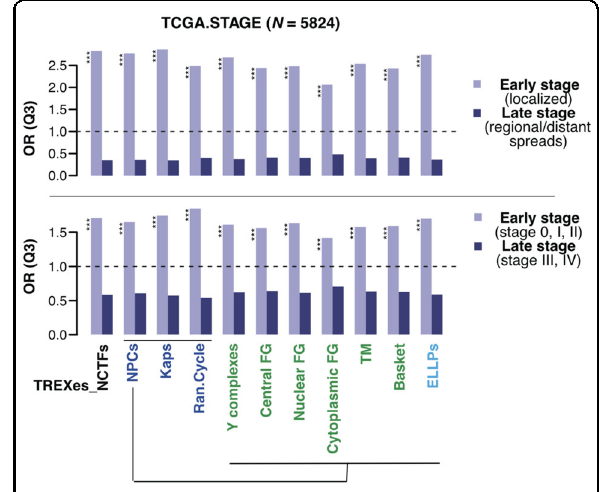
Fig. 5 TREXes and NCTFs show distinctive enrichment patterns by cancer stage. Comparison of the odds ratios of TREXes and NCTF subclasses in early- and late-stage cancers, as obtained from the GTEx database. Bar plot representing the odds ratios (ORs, Q3) of the NCTFs or their subclasses and TREXes. The light violet bar indicates the ORs in the early-stage cancer tissue, and the dark violet bar indicates thee ORs in the late-stage cancer tissue. Color legends on the x -axis are the same as those shown in Fig. 1e. Higher ORs indicate a greater likelihood of data being in